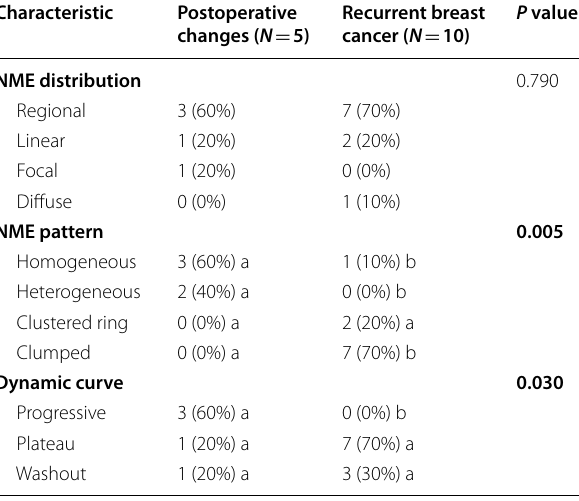
Table 1 Comparison between dynamic contrast enhanced MRI Table 2 Comparison between dynamic contrast enhanced MRI criteria of postoperative changes vs. recurrent breast cancer criteria of postoperative changes versus recurrent breast presented as mass lesions ( N 62) =